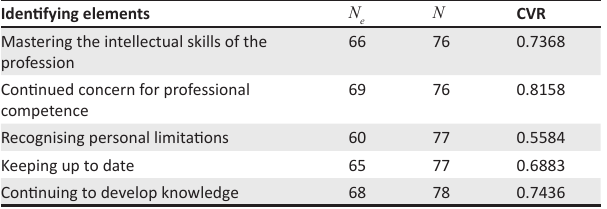
TABLE 16: Content Validity Ratio (Lawshe) of responsibility for knowledge and